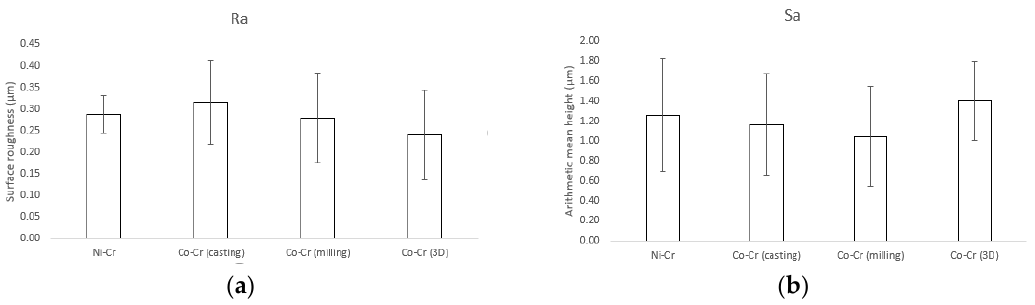
Figure 3. Surface roughness-related parameters obtained by confocal laser scanning microscopy (CLSM). ( a ) Ra (surface roughness), ( b ) Sa (arithmetic mean height deviation from a mean plane).